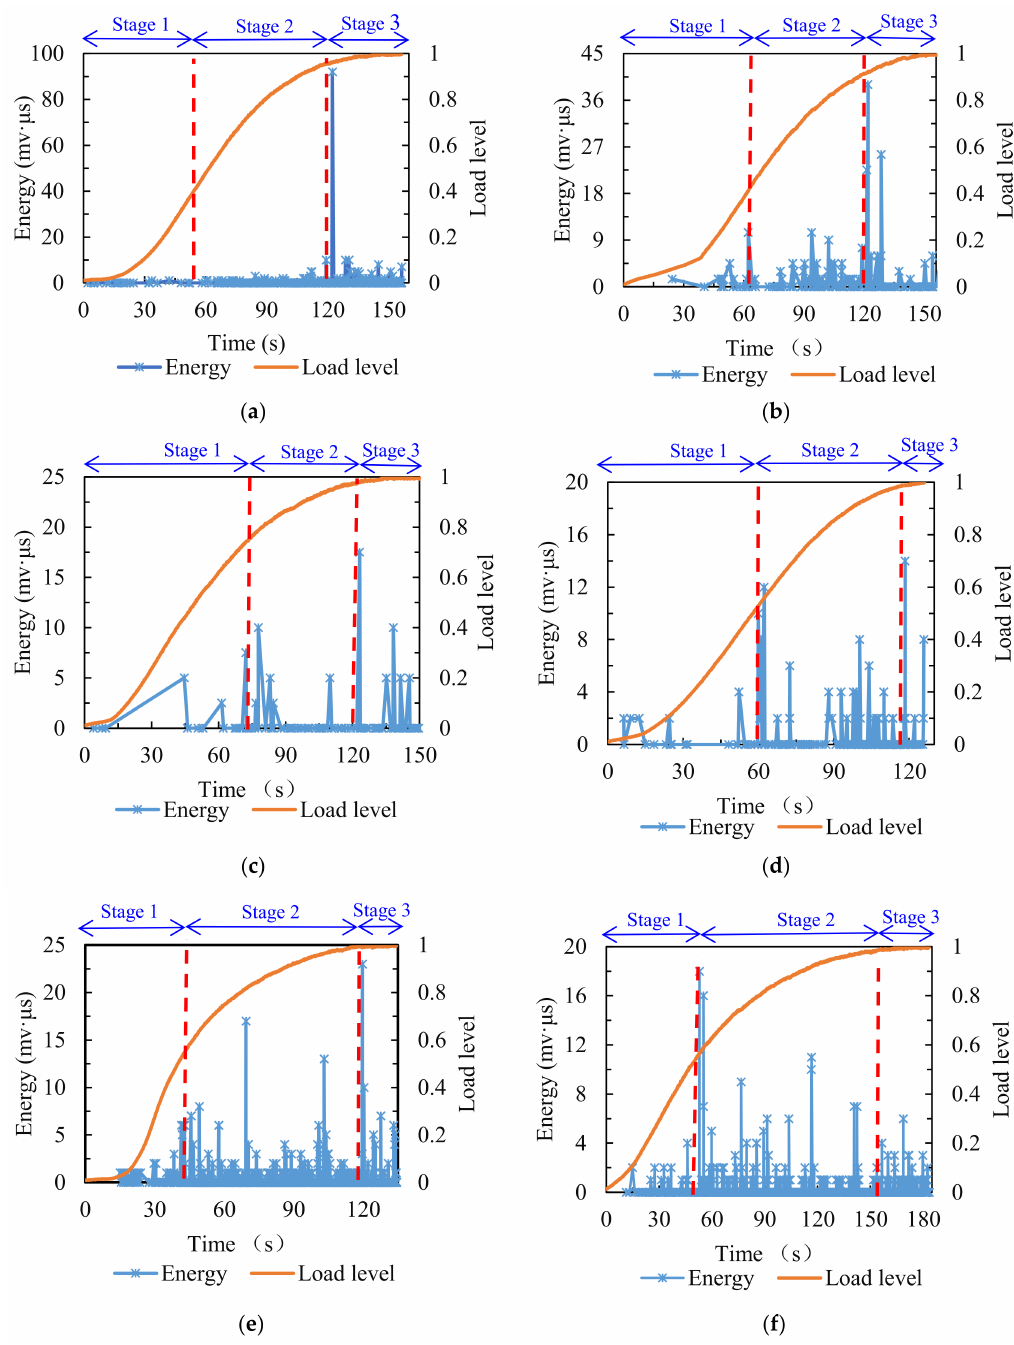
Figure 9. Energy distribution of specimens treated with various aging conditions: ( a ) 0 h; ( b ) STA; ( c ) LTA of 24 h; ( d ) LTA of 72 h; ( e ) LTA of 20 h; ( f ) LTA of 168